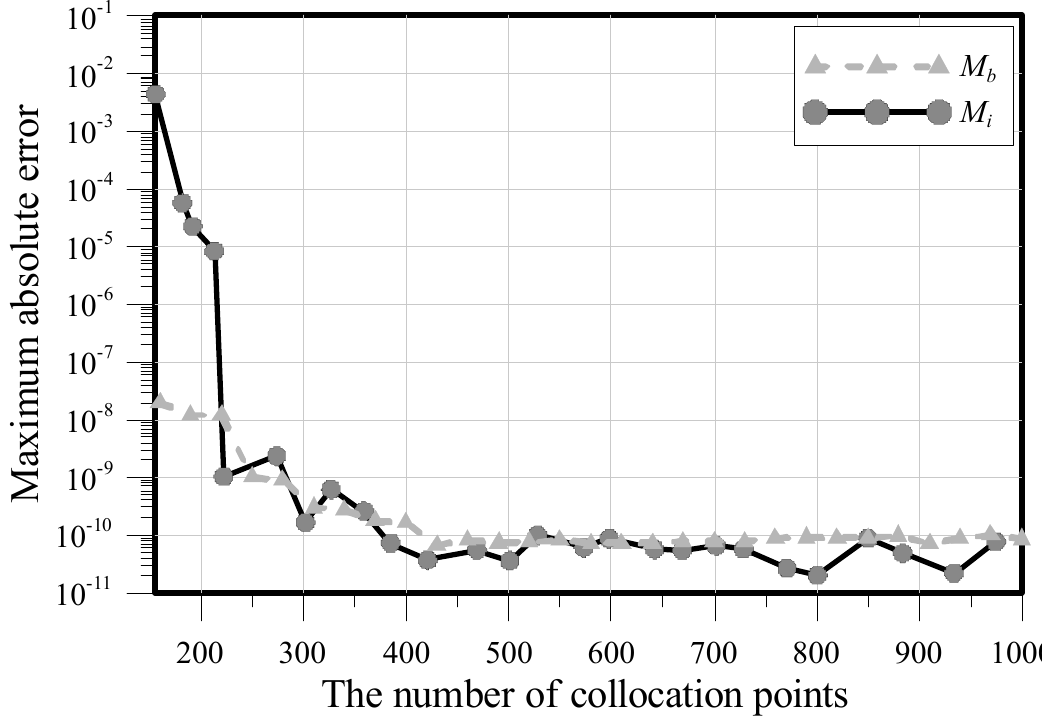
Figure 9. The boundary point number versus the maximum absolute error.